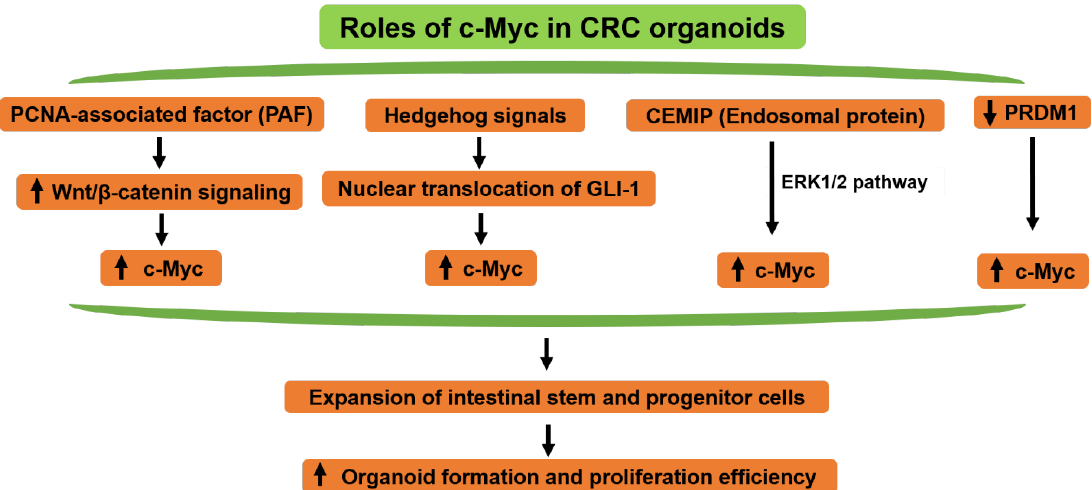
Figure 5. Roles of c-Myc in colorectal cancer (CRC) organoids. Overexpression of c-Myc results in expansion of the intestinal stem and the progenitor cells, which in turn increases organoid formation and proliferation. The mechanisms might be regulated by PCNA-associated factor ( PAF) / Wnt / β catenin signaling, Hedgehog signaling, cell migration-inducing and hyaluronan-binding protein (CEMIP)-dependent pathway through ERK1 / 2 or silencing the PR domain containing (PRDM)1 gene. The upper head arrows indicate increase while the lower ones indicate the consequences.